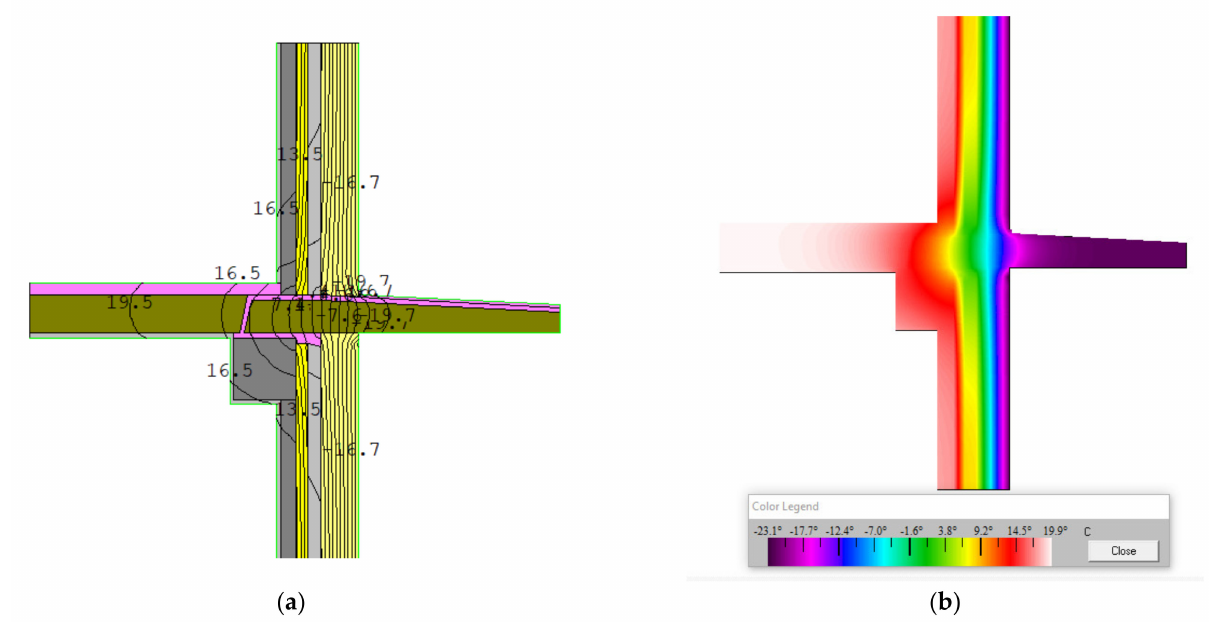
Figure 6. Temperature field in cross-section for scenario I, wall with 15 cm thick insulation: ( a ) isotherms ( b ) colour scale.